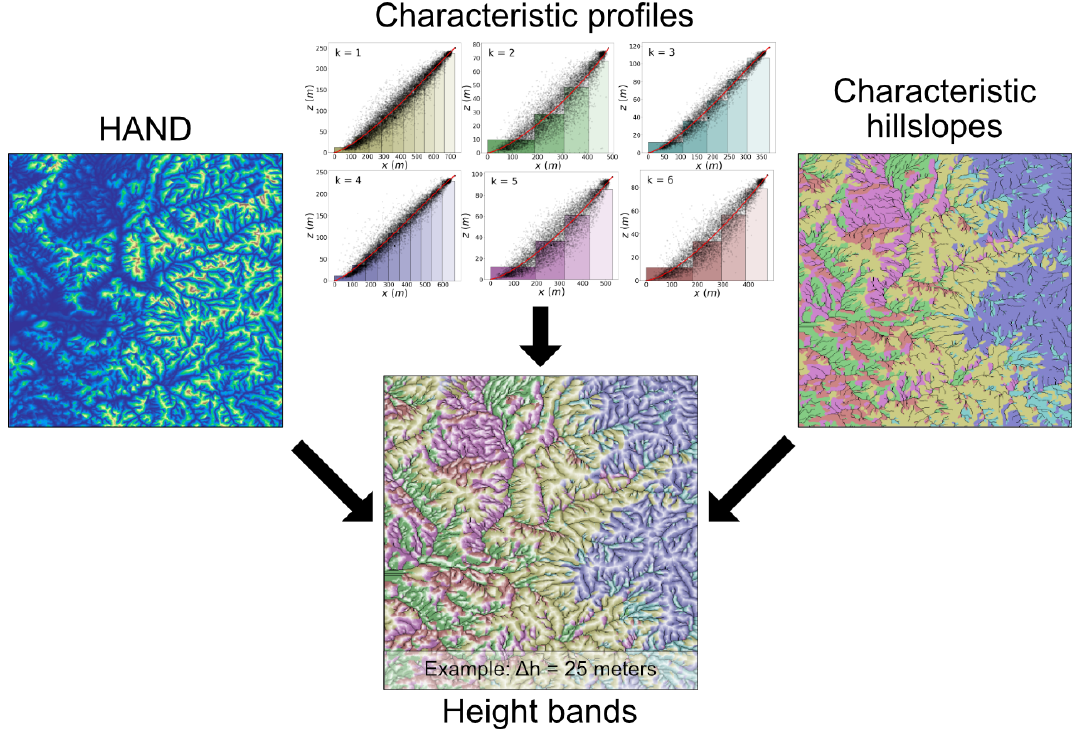
h i 1 − (cid:0) 1 − (x/L) a (cid:1) b to the combined profiles of all